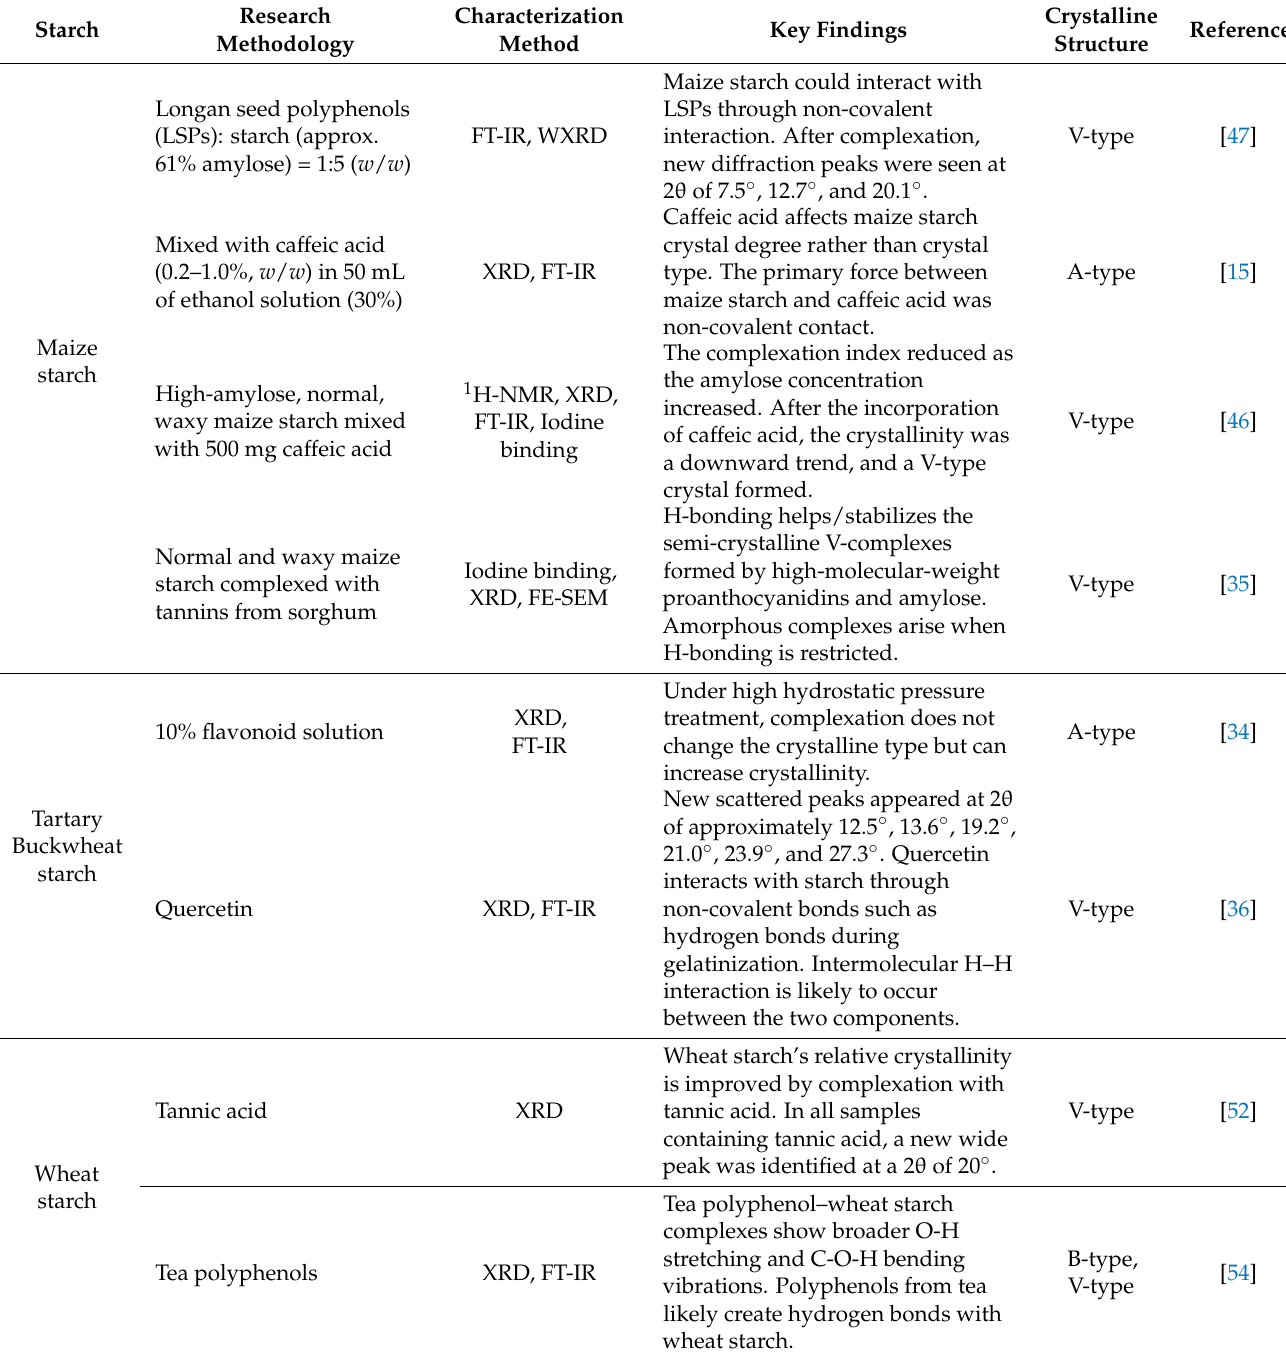
Table 2. Recent studies of the effects of polyphenol–starch complexation on starch